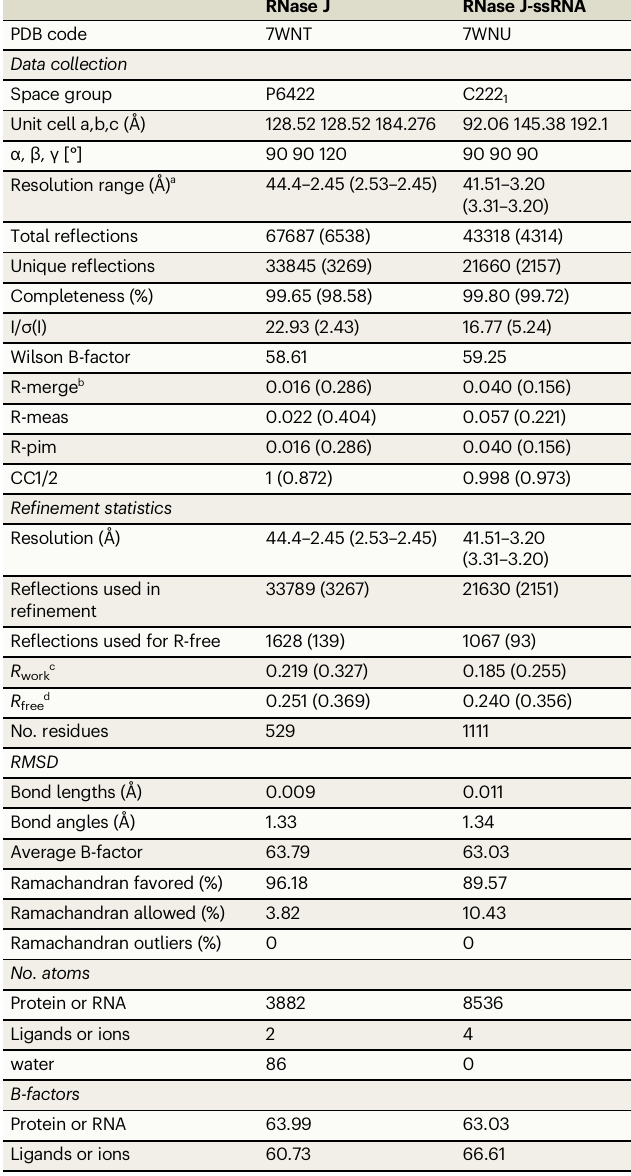
Table 1 | Data collection and re fi nement